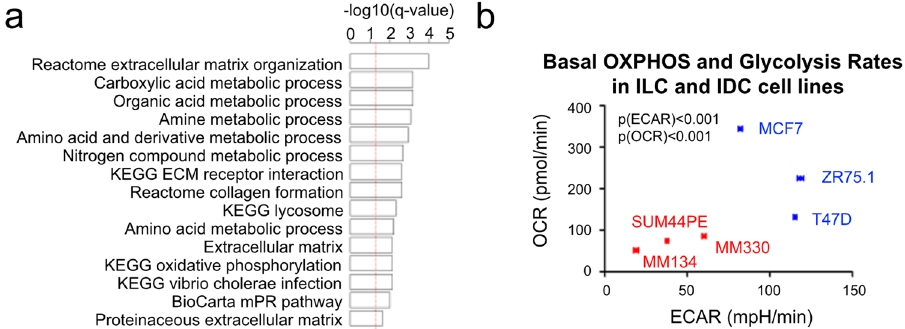
Figure 4. LumA ILC is more bioenergetically quiescent as compared to LumA IDC. ( a ) Top 15 inhibited pathway in LumA ILC compared to LumA IDC. –log10(0.05) is marked with red line. ( b ) The basal OXPHOS and glycolysis rate of ILC and IDC cell lines. Oxygen consumption rate (OCR) and extracellular acidification rate (ECAR), which are indicators of OXPHOS and glycolysis rates respectively were measured with Seahorse XF e 96 analyzer. Representative data of two independent experiments were presented. Data are mean ± SEM of 3 repeated measurements. Each measurement measured 6 or 8 biological replicates. Two-way ANOVA, p-values for ECAR[p(ECAR)] and OCR[p(OCR)] between ILC and IDC cell lines were calculated